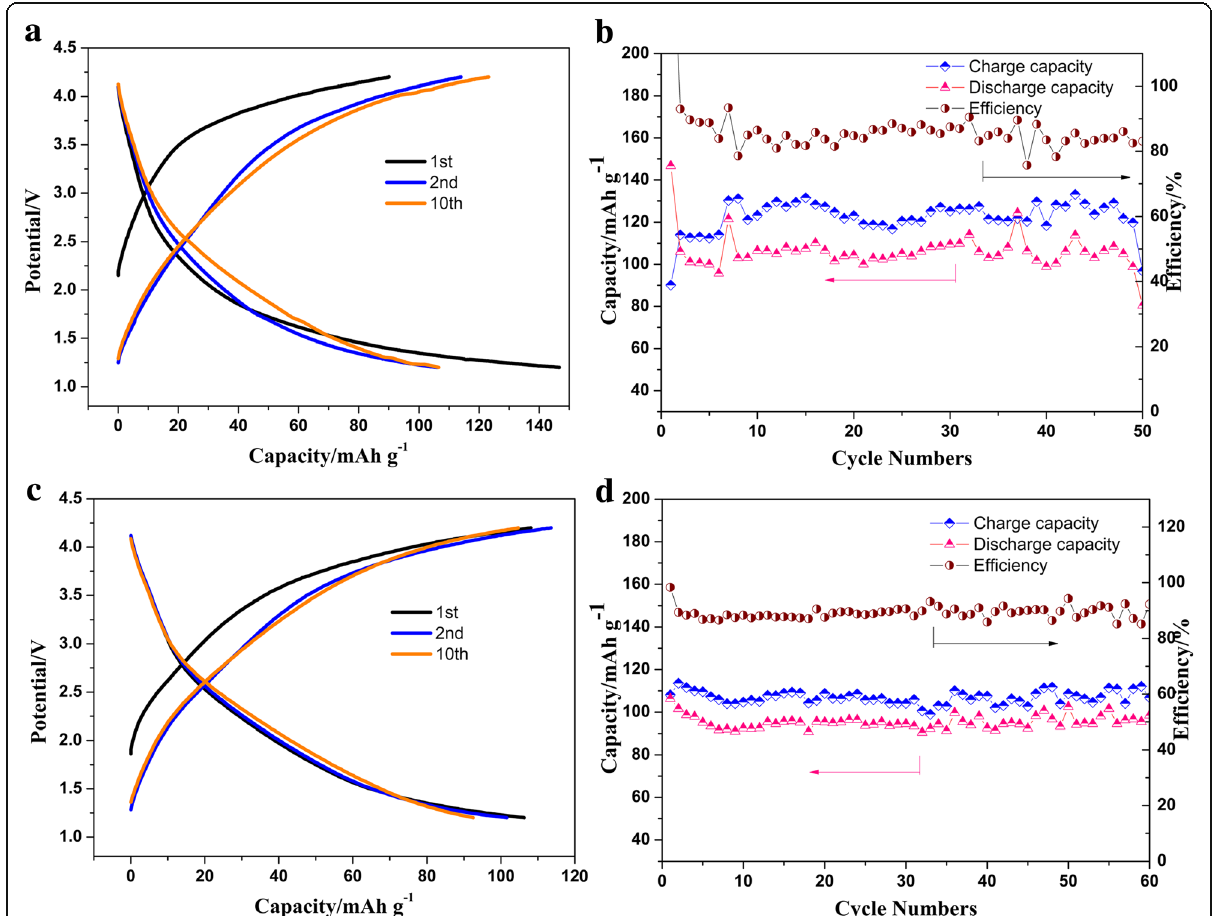
Fig. 5 Charge – discharge profiles for the different cycles of K(Mn 0.95 Ni 0.05 )F 3 ( a ) and K(Mn 0.95 Ni 0.05 )F 3 /MWCNTs ( c ), and the corresponding capacity- cycle profile of